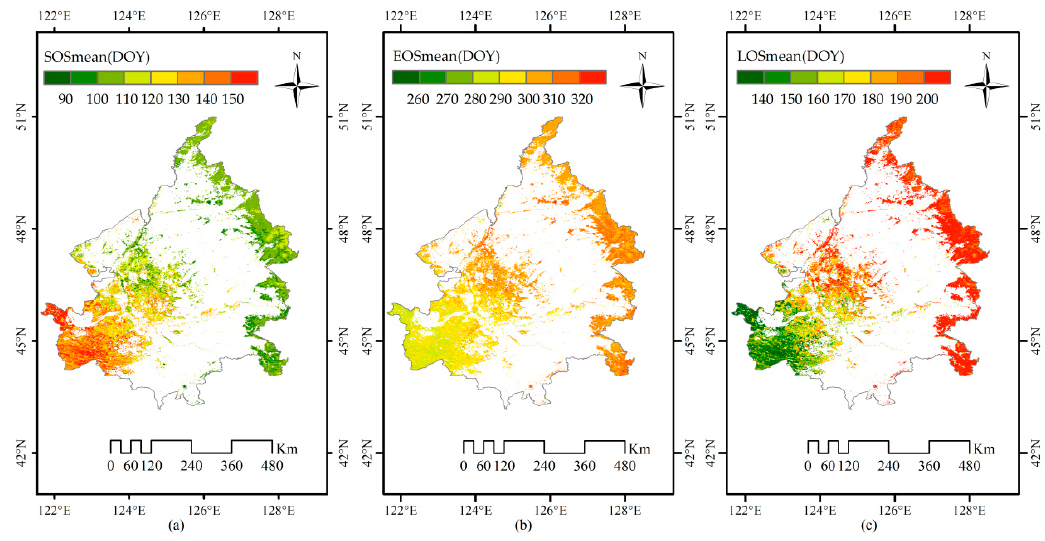
Figure 9. Spatial distribution of land surface phenology metrics in the SNP from 2001 to 2015: ( a ) average SOS; ( b ) average EOS; ( c ) average LOS.